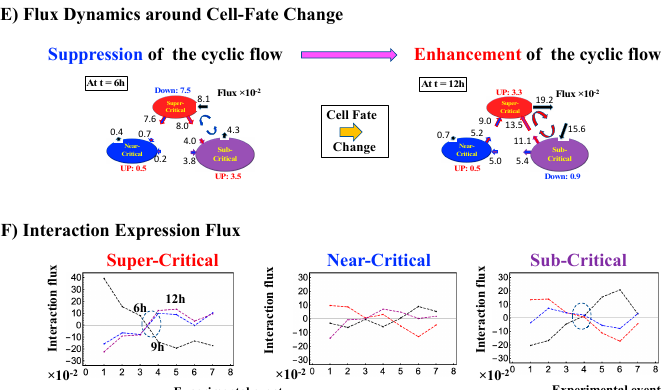
Figure 15. Single cell: mechanism of the cell-fate change through perturbation of the genome engine. ( A ) and ( B ) mouse embryo development; ( C ) and ( D ) human embryo development; ( E ) and ( F ) Th17 immune cell differentiation. As in cell-population responses, in the case of single cell, before reprogramming as well as cell differentiation, the interaction flux dynamics (the dashed oval: ( B ), ( D ), ( F )) also intersect each other. Notably, reprogramming of embryo development (more evident in the mouse embryo) and cell differentiation in Th17 immune cells occurs through suppression–enhancement of the dominant cycle state flux between super- and sub-critical states. Numerical values based on 10 − 1 for embryo cells and 10 − 2 for Th17 cells represent between-state expression flux.